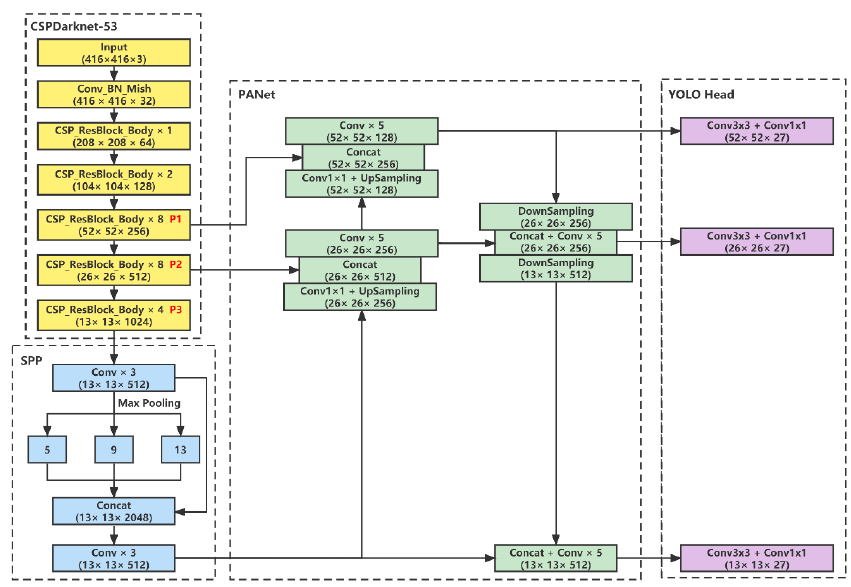
Figure 5. Architecture of YOLOv4. In the figure, the yellow part is the backbone network (CSPDark- net53), the blue part is the SPP module, the green part is the PANet module and the purple part is YOLO Head.